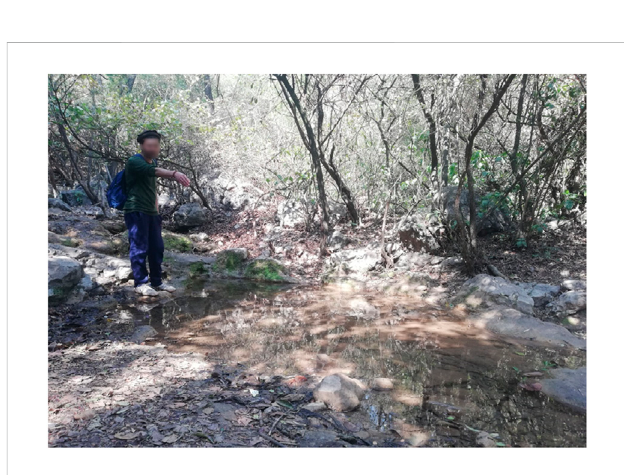
FIGURE 10 Streams spotted along Trail-5 during the